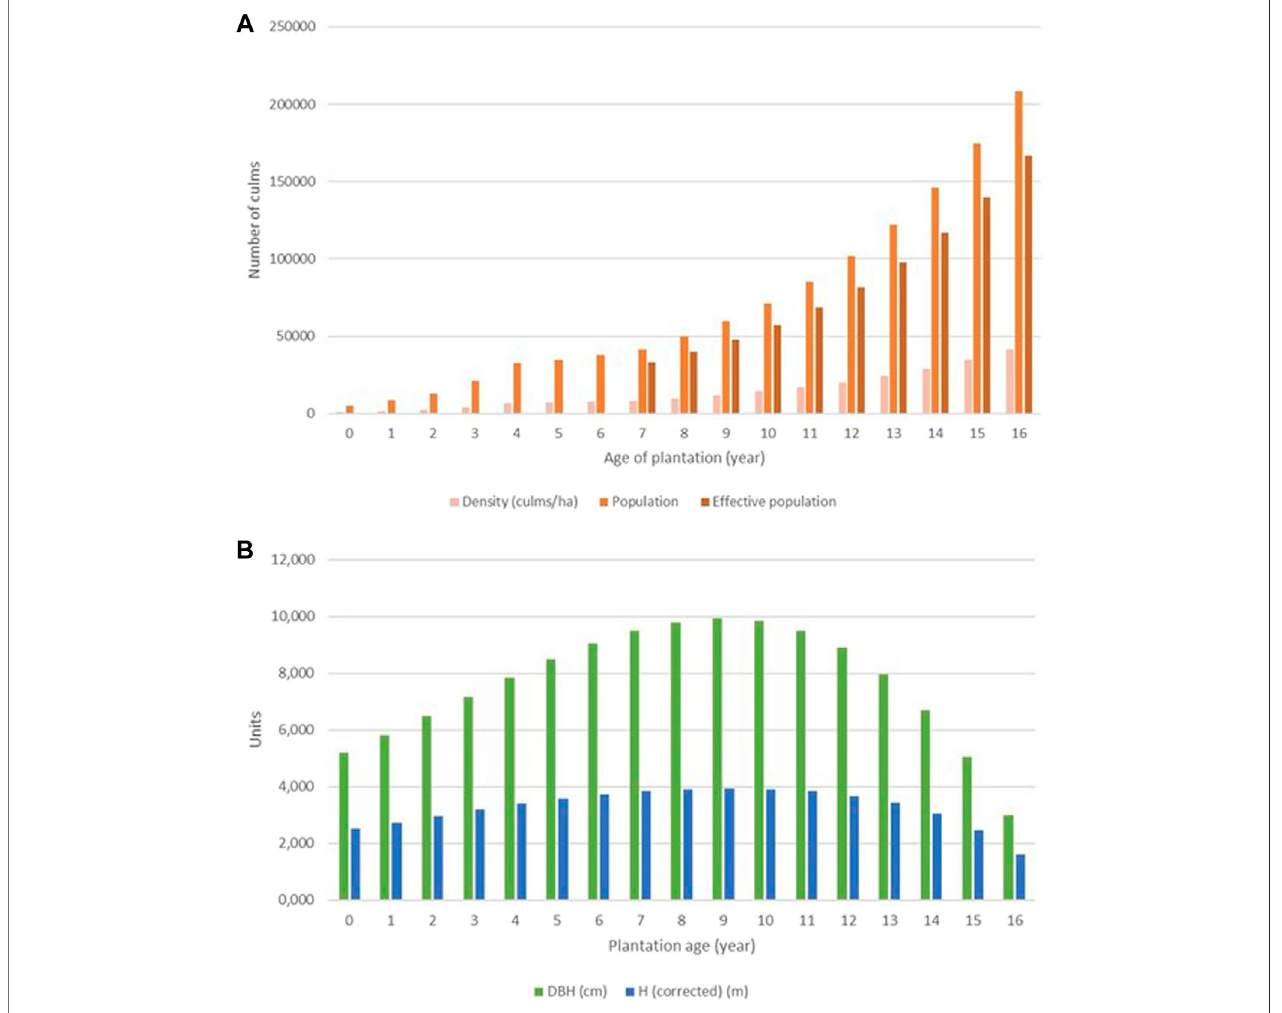
FIGURE 2 | (A) Pattern of culm change during a timeframe of 16 years. Population : total number of bamboo individuals. Effective population : number of culms net of the cut fraction; (B) Culm changes in the time interval 0 – 16 years of bamboo plantation development. DBH = diameter at breast height; H = corrected culm height.